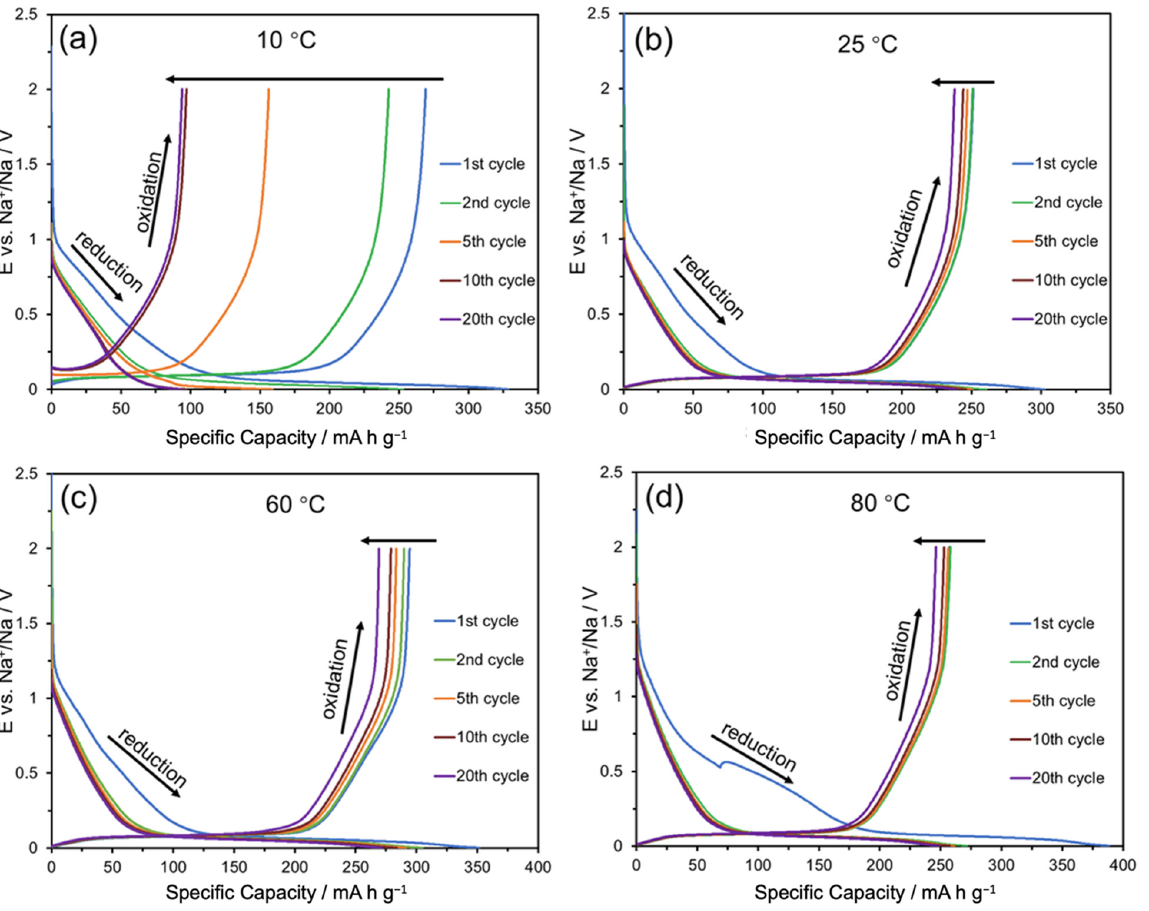
Figure 5. Voltage-capacity plots of galvanostatic cycling data at 100 mA g − 1 current for HC at the 1st, 2nd, 5th, 10th and 20th cycle at ( a ) 10 °C, ( b ) 25 °C ( c ) 60 °C and ( d ) 80 °C.